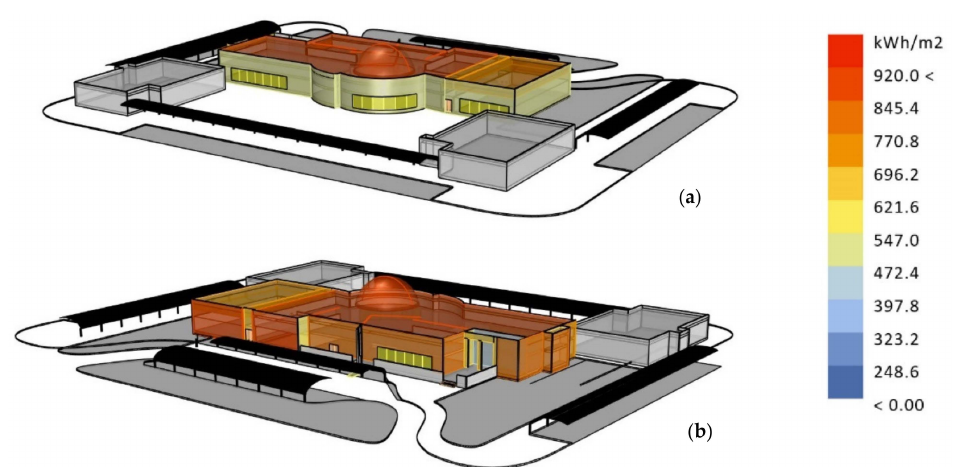
Figure 11. Energy calculation of the base model: ( a ) north view, ( b ) south view.